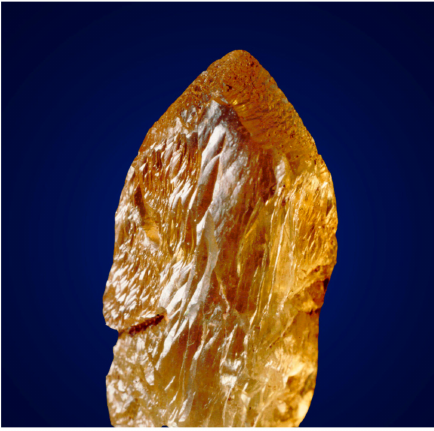
Figure 10. Barite, Chub Lake prospect. 2.3 cm. Chamberlain Collection, NYSM C12184. SC.